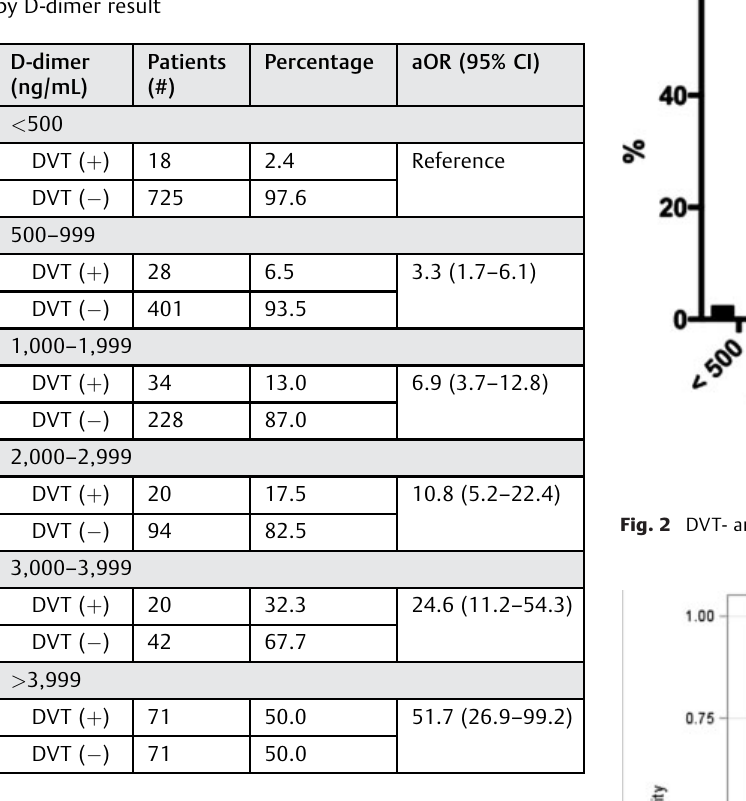
Table 2 Proportion of DVT-positive and DVT-negative patients by D-dimer result